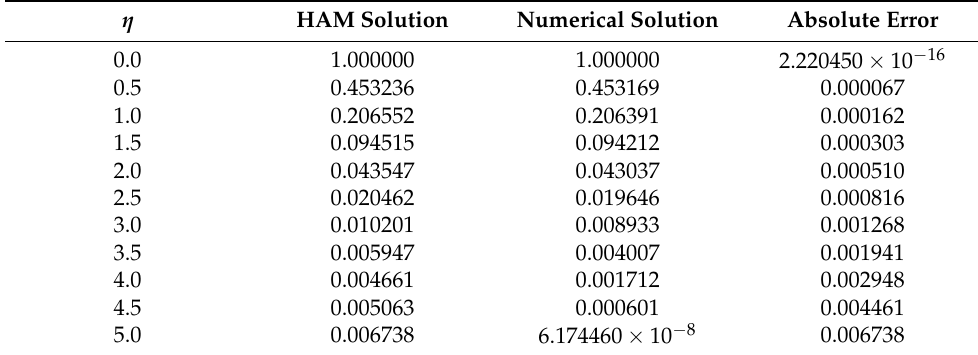
Figure 17. Error decay for the 10th-order approximation. Table 2. Comparison of (Au-Cu)/Ethylene hybrid nanofluid velocity.